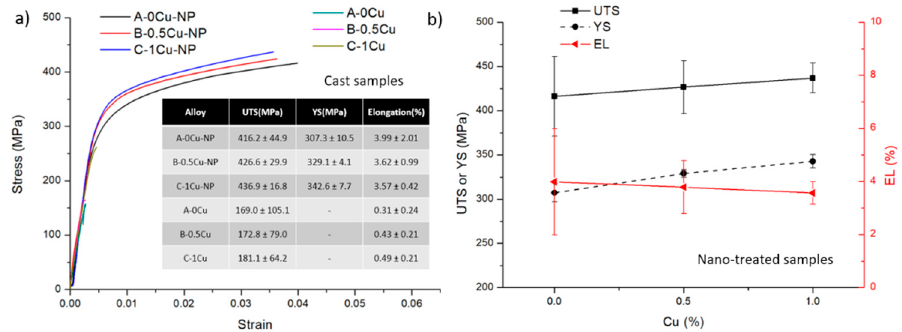
Figure 8. ( a ) Tensile testing of all samples aged for 40 days after casting. The inserted table contains tensile data. ( b ) Comparison of the corresponding UTS, YS, and EL values of the nano-treated samples.